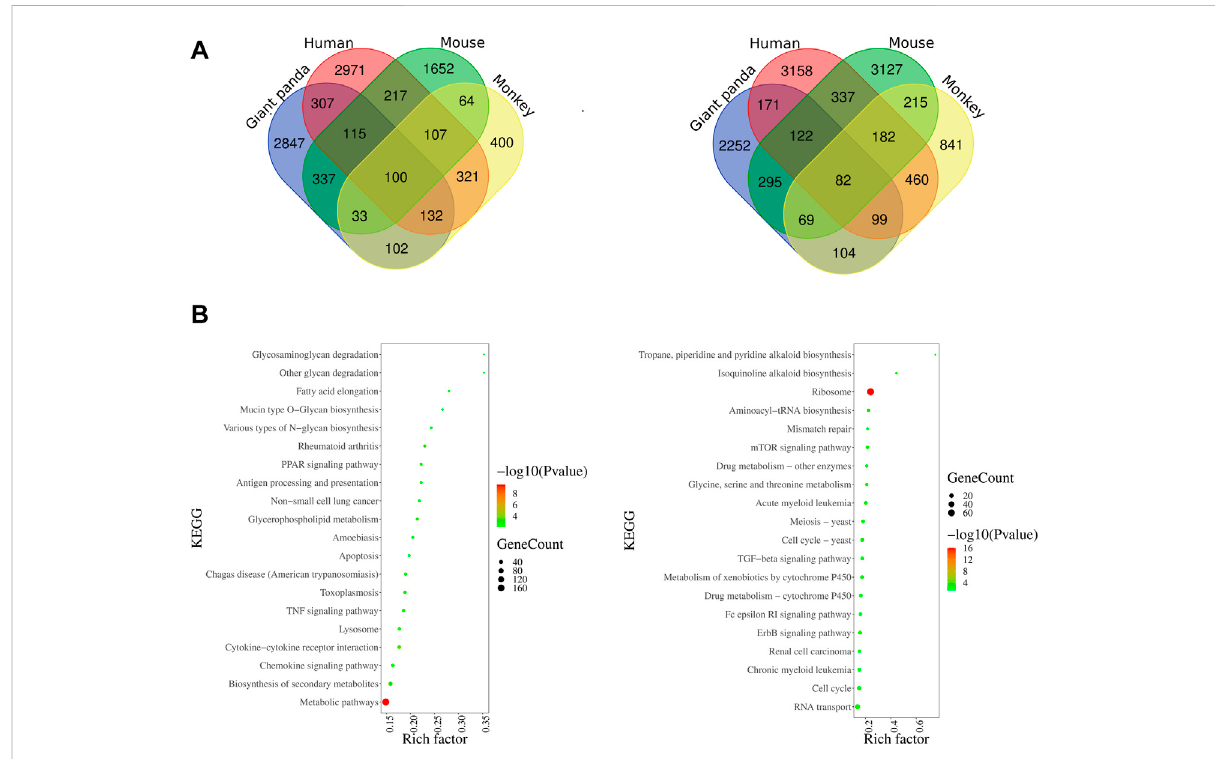
FIGURE 4 Venn diagram of DEGs among four species and KEGG enrichments of giant panda ’ s unique DEGs. (A) Overlapping upregulated and downregulated DEGs among giant pandas, humans, mice, and monkeys. (B) KEGG enrichments of giant panda ’ s unique upregulated and downregulated